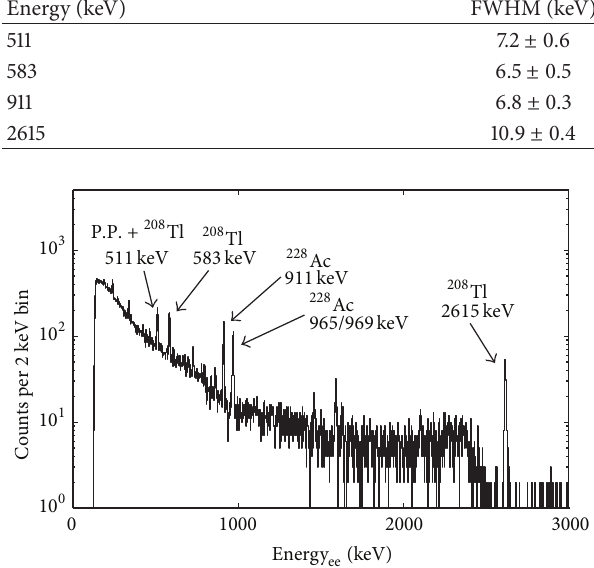
Figure 6: Energy spectrum measured with an external source over 65